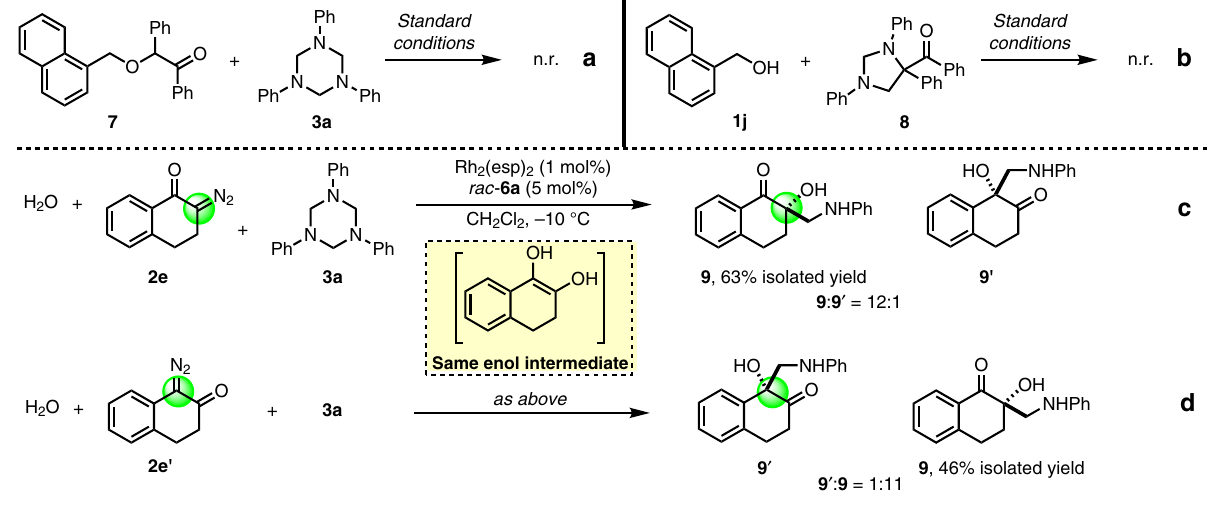
Fig. 7 Mechanistic studies. a Control reaction to exclude the formation of product 5j from insertion product 7 . b Control reaction to exclude the formation of product 5j from cycloaddition product 8 . c , d Control reactions to verify the involvement of enol intermediate with diazo ketone 2e and 2e ’